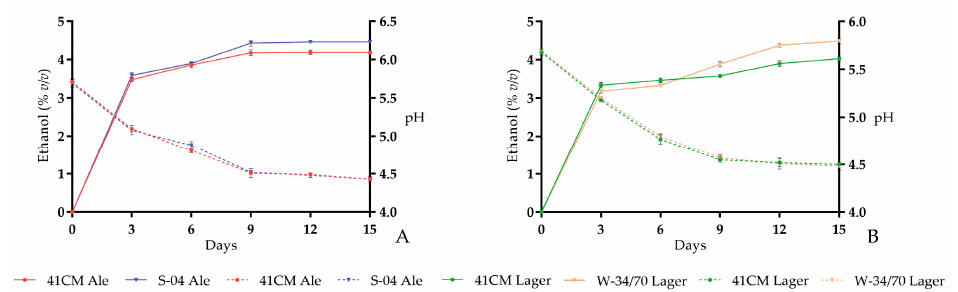
Figure 1. Evolution of pH (dashed lines) and ethanol (continuous lines) during the primary fermentation of ale ( A ) and lager ( B ) beers. Error bars indicate ± SD ( n = 3).